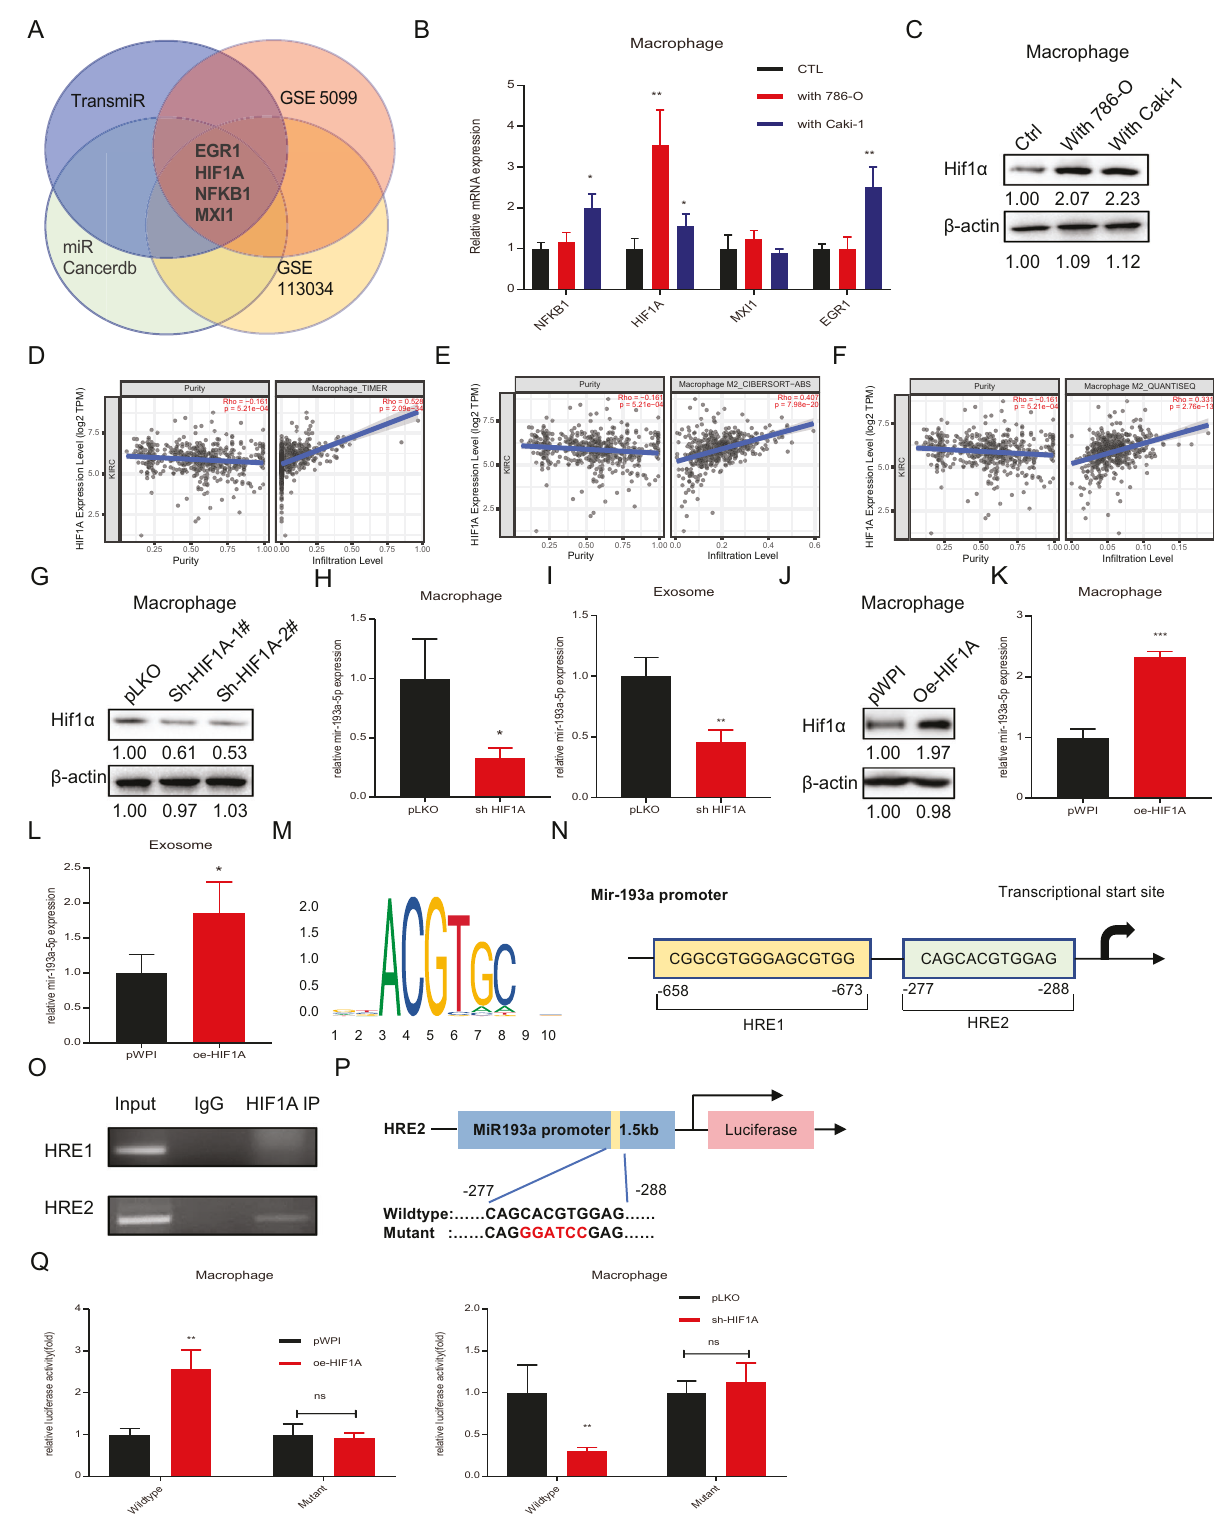
Cell invasion assay Transwell chambers (8- μ m pore size) (Corning Life Science) were used for the cell invasion assay. The upper chamber was fi lled with 100 μ l of diluted Matrigel (1:10 dilution) and incubated for 2 h at 37 °C. Then, 150 μ l of serum-free medium containing 5 × 104 RCC cells were added